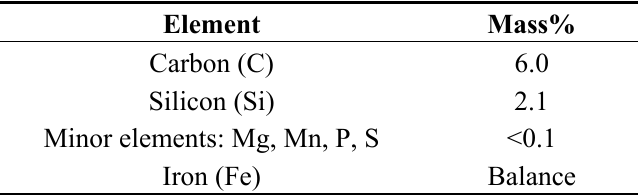
Table 1. XRF composition of elements in cast iron